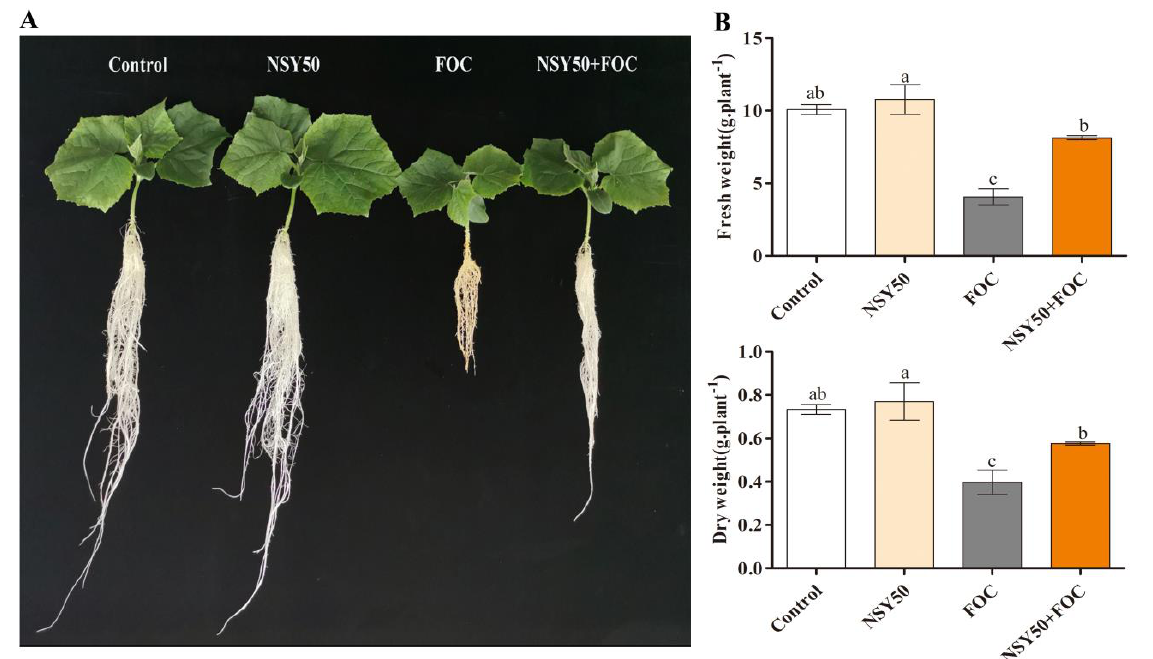
Figure 1. Effects of plant-growth-promoting bacteria-NSY50 on the growth of cucumber seedlings under Fusarium wilt stress. ( A ) Phenotypes images, ( B ) Fresh and dry weight. Values are the means ± SD, n = 3 (biological replicates), and different letters (a > b > c) indicate a significant difference at p < 0.05, as determined by Duncan’s multiple-range test.